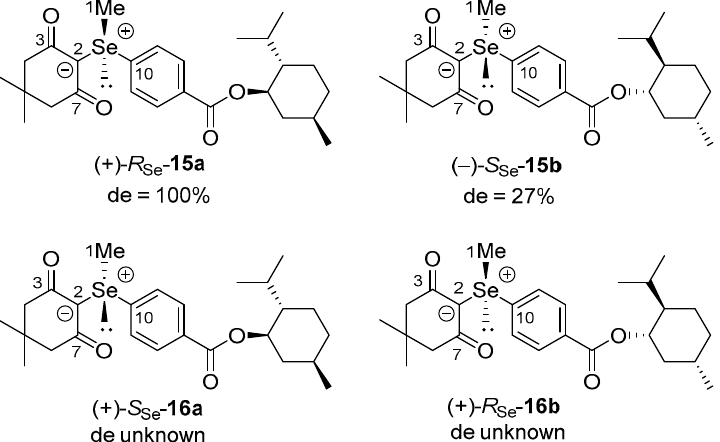
Figure 8. Diasteroisomerically pure selenonium ylide 15a and diastereoisomerically enriched ylides 15b and 16a,b .